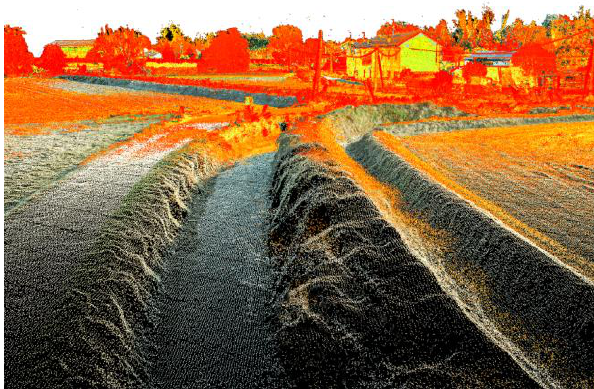
Figure 3. Point cloud integrated between MLS and drone photogrammetry. Second case study: irrigation systems of the agricultural system of the Pavia plain.